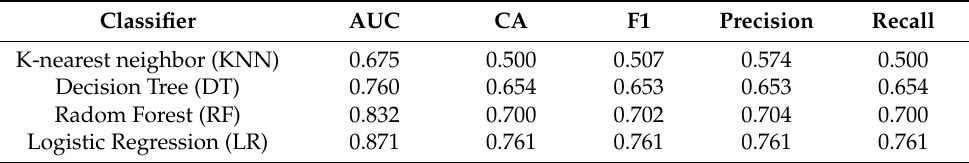
Table 4. Results of classifier model for fear, anger, and surprise.